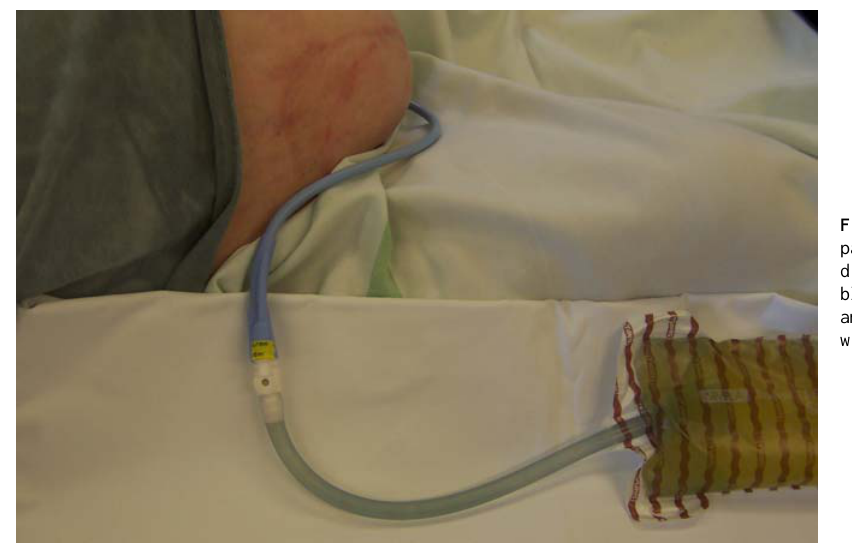
FIGURE 1 . Clinical photograph of the patient showing the suprapubic catheter, drainage tube, and urine bag. There is bluish discolouration of the drainage tube and, to a lesser degree, the urine bag as